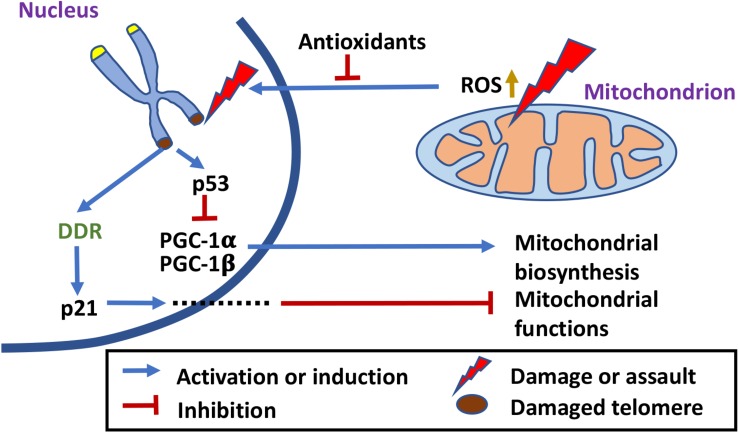
Telomerase-independent trafficking and functions of TERC. TERC is imported into mitochondria, processed to TERC-53, and then exported back to the cytosol where it inhibits nuclear translocation of GAPDH (Luhtala and Parker, 2010; Hillwig et al., 2011; Liu et al., 2017; Cheng et al., 2018; Huang et al., 2018). Cytosolic TERC-53 relays the signal of mitochondrial defects to the nucleus and is involved in cellular senescence and organismal aging. Nuclear TERC can also bind directly to the promoter regions and upregulate transcription of genes that are involved in inflammatory response (Liu et al., 2019).